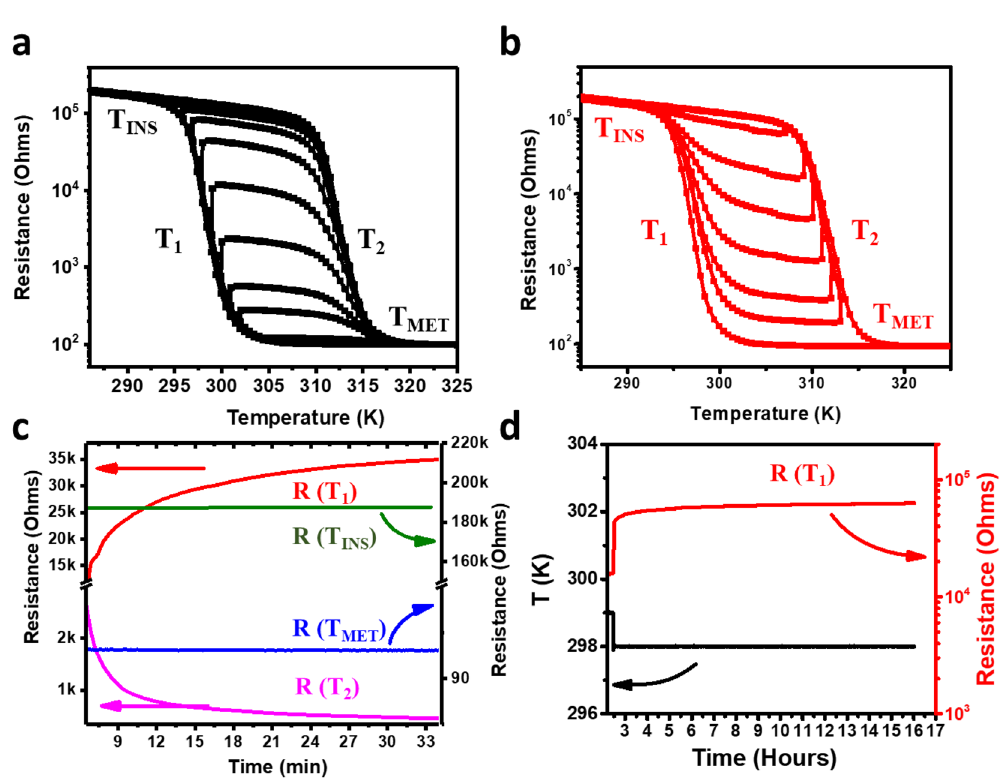
Figure 2. Multiple stable resistance states can be achieved when temperature sweeps are reversed. ( a ) Shows this effect when a cool down is reversed during the transition near T 1 , and ( b ) is for the case that warming up is reversed during the transition near T 2 . ( c ) Time-evolution of the different resistive states on a logarithmic scale showing the highly insulating state at T INS , the completely metallic state at T MET , and an intermediate resistance when keeping the temperature fixed at a given T 1 during cooling or at a given T 2 during heating. ( d ) The R(T 1 ) on a linear scale vs longer time scale, showing the stability of the intermediate state after initial relaxation when switching the temperature from 299 K to 298